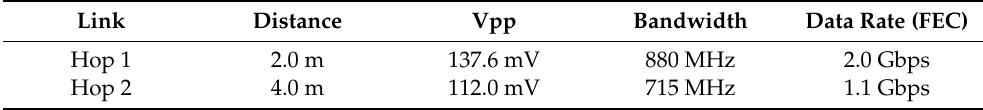
Table 2. Communication-performance comparison from Hop 1 and Hop 2.